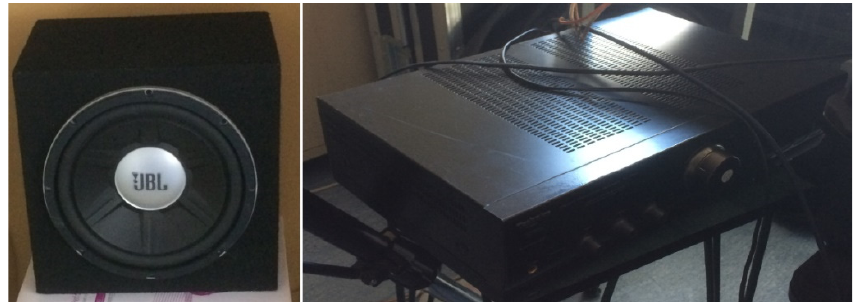
Figure 2. Measurement tools and research stand, the left low-tone JBL GTO 1214 loudspeaker, the right Technics SU-A700 stereo amplifier.